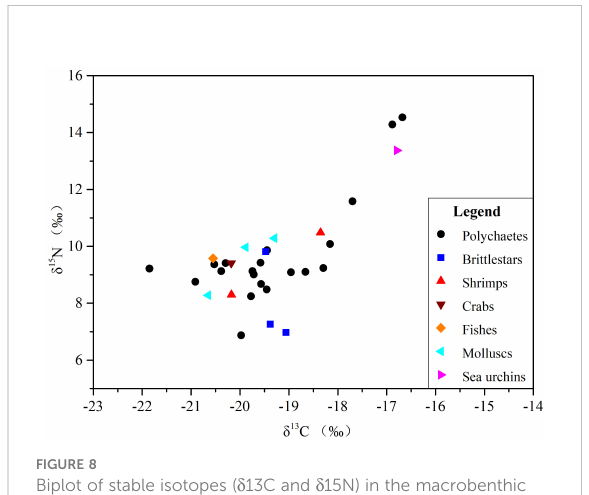
FIGURE 8 Biplot of stable isotopes ( d 13C and d 15N) in the macrobenthic taxa analysed from the